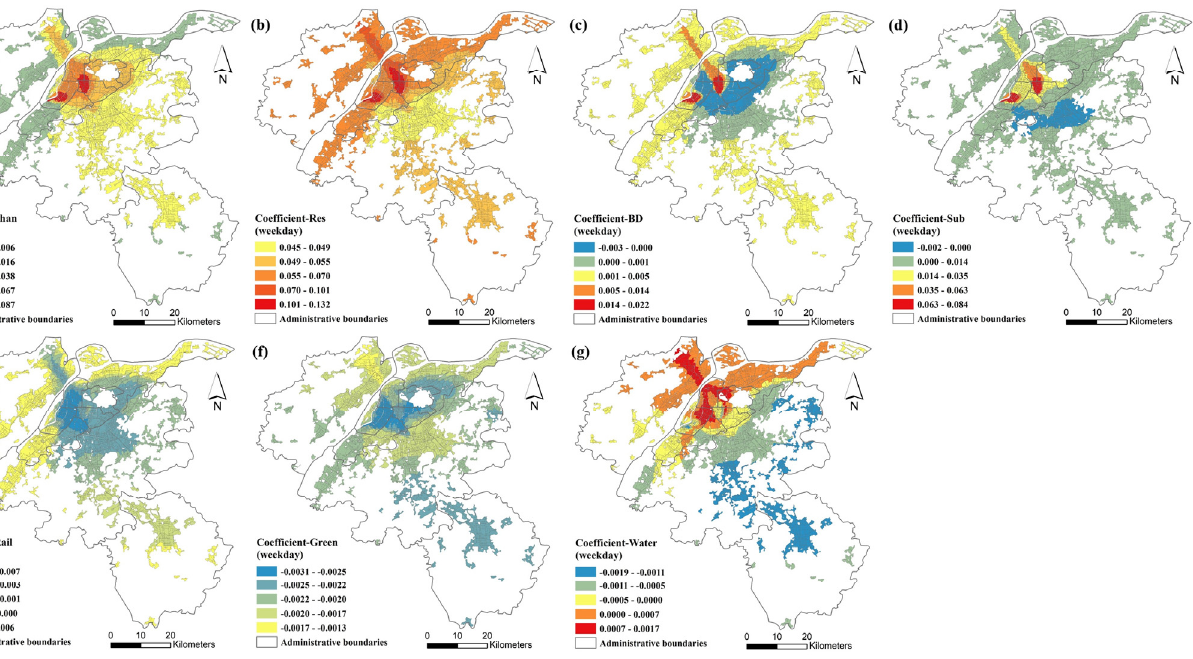
Figure 14. Net regression coefficients: ( a ) weekdays and ( b ) weekends.